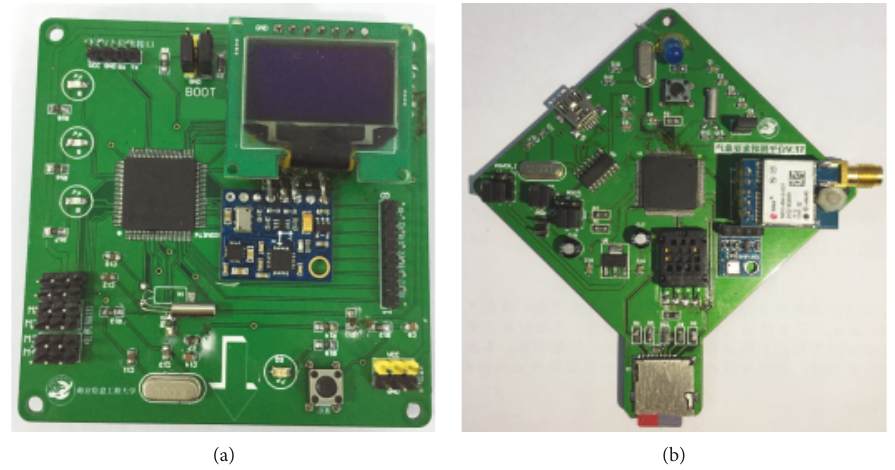
Figure 17: (a) Flight control board. (b) Detection board.